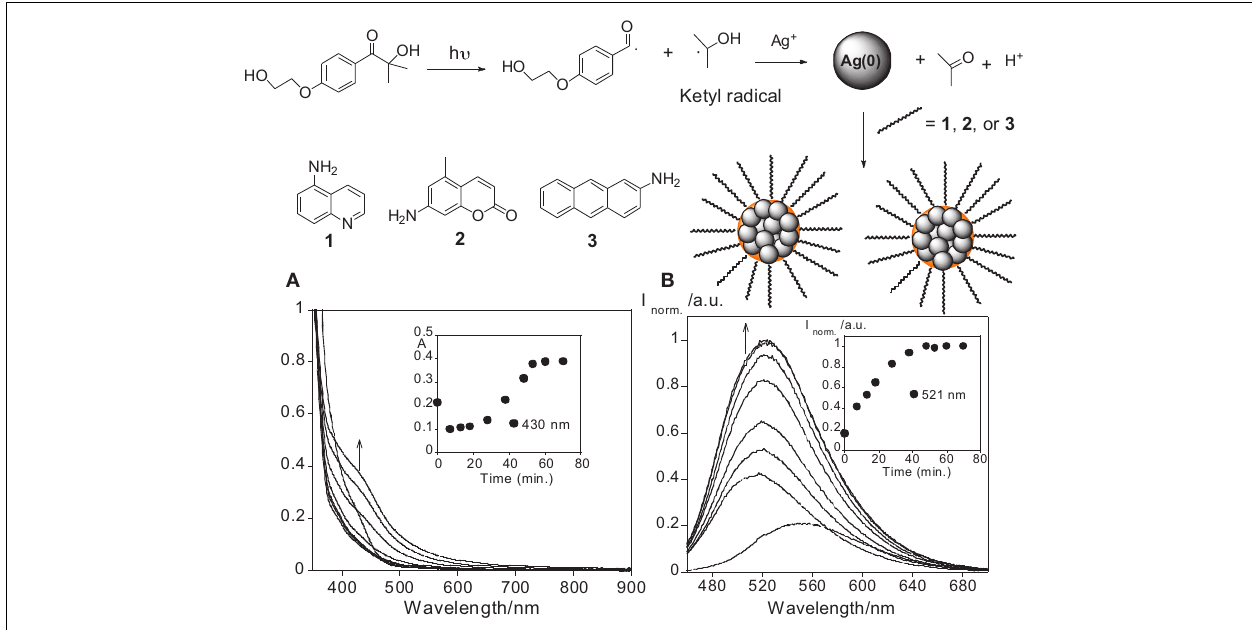
FIGURE 1 | Above: General synthetic pathway of the AgNPs synthesis. Below: (A) Absorption and emission (B) spectra of the AgNPs formation with time containing as additive compound 1 , in a THF solution, T = 298K, λ exc = 430nm.